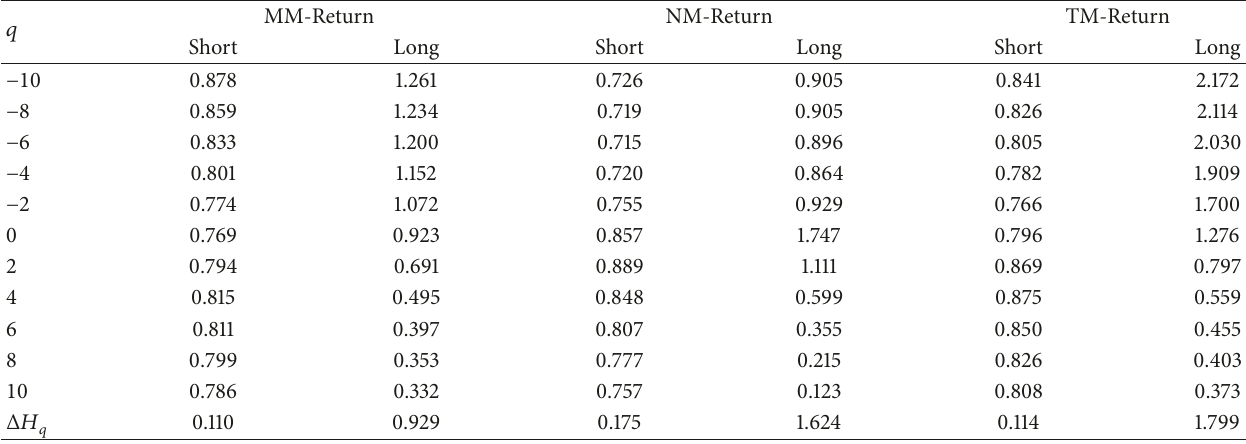
Table 2: Short term and long term scaling exponents between news and return series. This table reports the short term and long term scaling exponents for the series between the mass media news and return of SSE 50, new media news amount and return of SSE 50, and total news amount and return of SSE 50. The signal “MM-Return” denotes the scaling exponent of mass media news amount and return of SSE 50, “NM-Return” is the scaling exponent of new media news amount and return of SSE 50, and “TM-Return” denotes the scaling exponent of